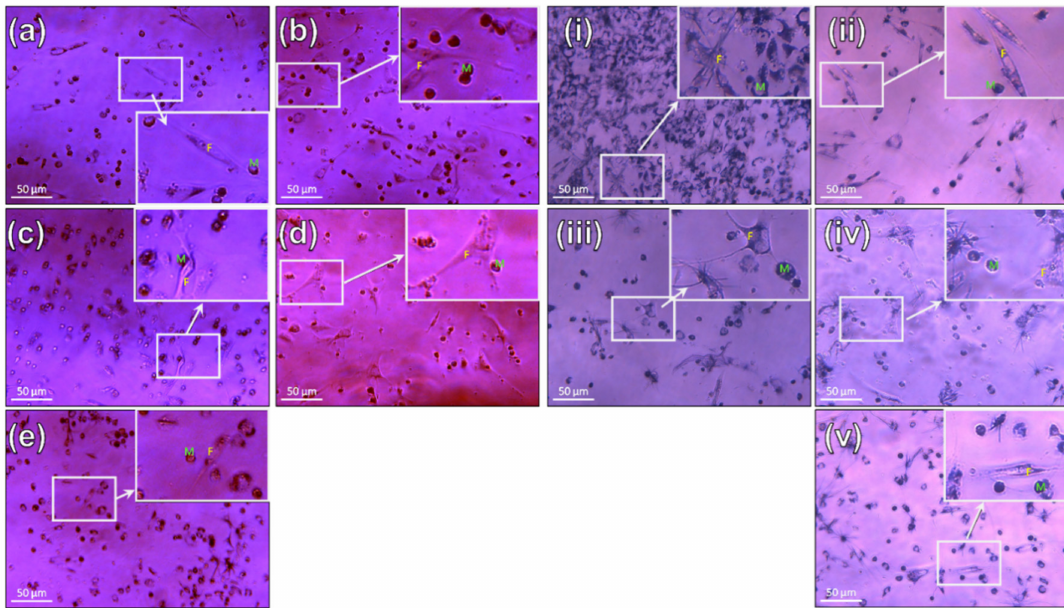
Figure 8. Macrophage and fibroblast co-culture post-MTT observed with OPCM at 3 days ( a – e ) and 5 days ( i – v ) of incubation (200 × ): ( a , i ) control; ( b , ii ) conditioned medium with AISI 316L steel eluates; ( c , iii ) conditioned medium with a-C:5H coating eluates; ( d , iv) conditioned medium with a-C:10H coating eluates; ( e , v ) conditioned medium with artificial